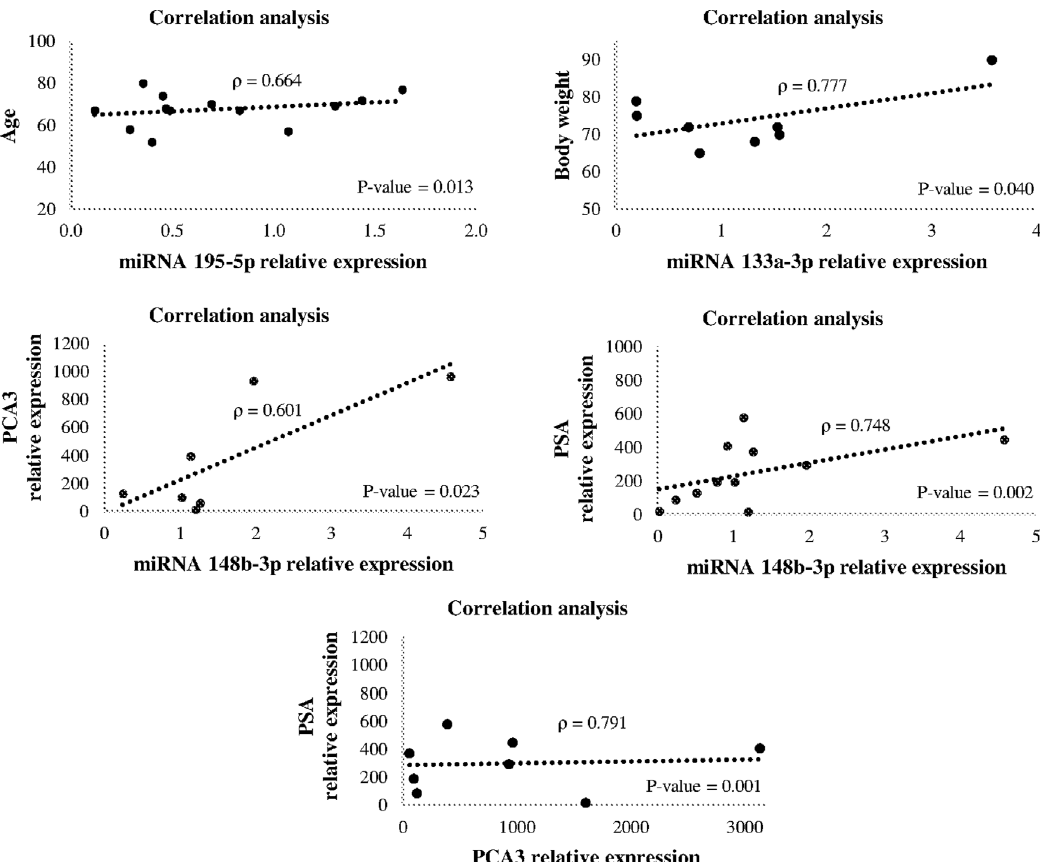
Figure 3 - Correlation analysis between expression levels of miRNAs, clinicopathological characteristics, PSA , and PCA3 genes. The correlation coeffi- cient of 0.664 with p -value < 0.05 indicates that miR-195-5p expression was moderately correlated with age in PCa patients. Also, there was a strong cor- relation between body weight and miR-133a-3p expression with a correlation coefficient of 0.777 ( p < 0.05). There was also a moderate correlation be- tween miR-148b-3p and PSA or PCA3 expressions with a correlation coefficient of 0.601 and 0.748, respectively. Correlation coefficient of 0.791 ( p < 0.05) indicated a strong correlation of PCA3 with PSA